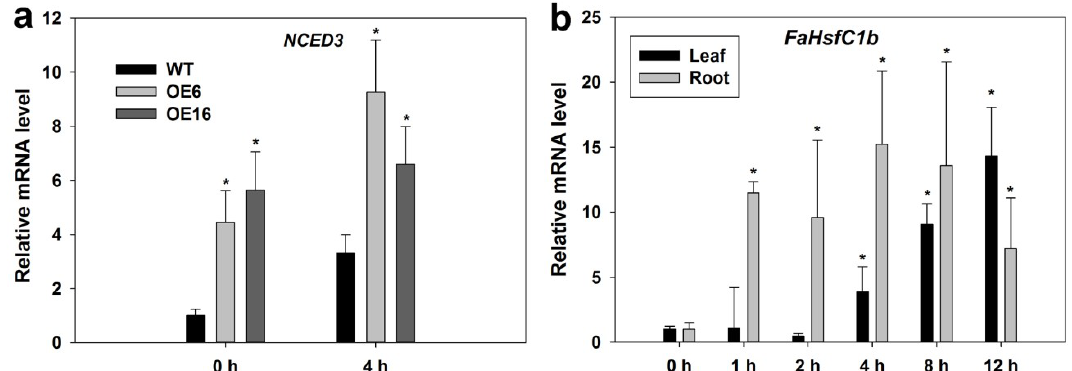
Figure 11. Relative mRNA expression levels of NCED3 and FaHsfC1b. ( a ) Relative mRNA expression levels of NCED3 in WT and transgenic Arabidopsis plants. OE6 and OE16 were selected to be tested in thermal environment (37 °C) and leaf samples were collected at 0 h and 4 h after heat stress. Values were means ± SD of three different biological replications (with two technical replications for each biological replication). Asterisks indicated significant differences between means of WT and transgenic lines at each time period according to Fisher’s protected LSD test ( p < 0.05). ( b ) Relative mRNA expression levels of FaHsfC1b in leaves and roots under 100 µM ABA treatment in tall fescue. qRT-PCR values were means ± SD of three biological repetitions (three technical repetitions for every biological repetition). Asterisks indicated significant difference of mean values at each time period of stress treatment regarding the value at 0 h (nontreated plants) for each tissue analyzed (root and leaf).